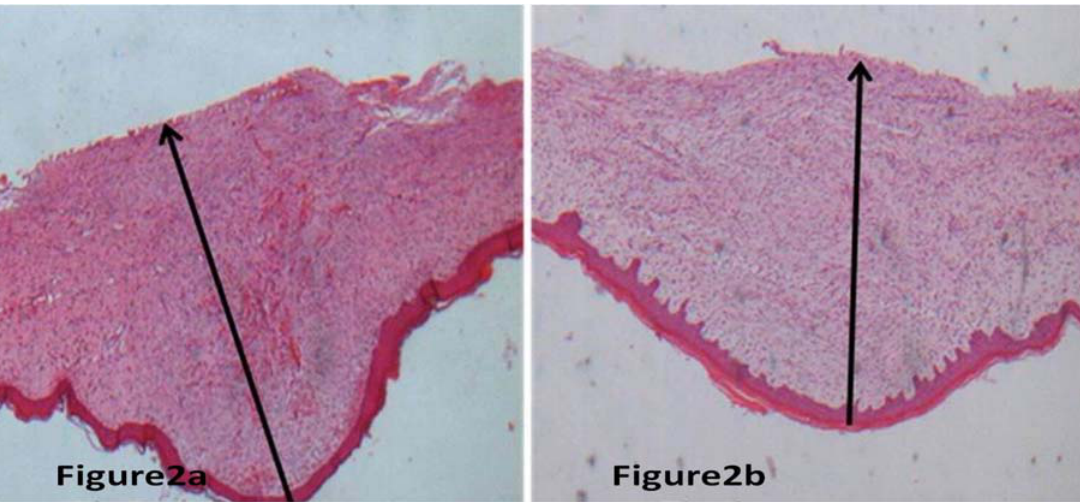
Figure 2. Represented hypertrophic scar stained by H&E stain. Measurement of the thickness of scar at 100 magnification. Figure 2a,b represented scar without BTXA treatment and the scar received BTXA treatment, respectively. Through the microscopic observation, it was found that the thickness of scar received BTXA treatment was thinner than that of scar without BTXA